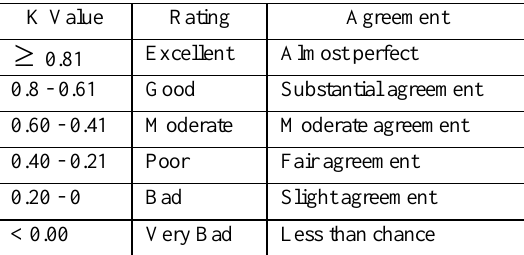
Table 11: Interpretation of